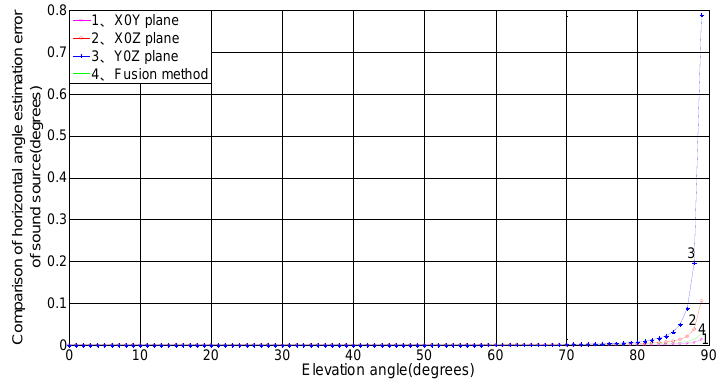
Figure 3. Comparison and analysis of the horizontal angle estimation error of the sound source caused by an elevation angle change.